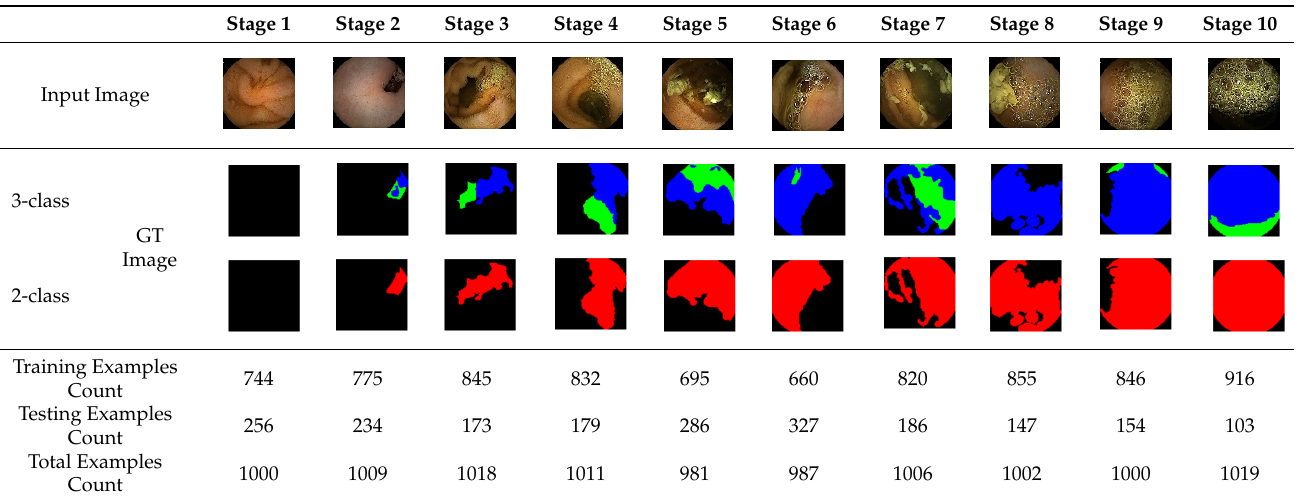
Table 2. Training samples and GT images for each visualization scale stage and its corresponding statistics. Images from capsule endoscopy (top row), 3-class ground truth region images (second row). Black, green, and blue denote clean, dark, floats/bubbles regions, respectively. 2-class ground truth region images (third row). Black and red denote clean and non-clean regions, respectively. The statistics of training/testing samples for each stage (bottom three rows). Measuring unit: images, GT: ground truth.